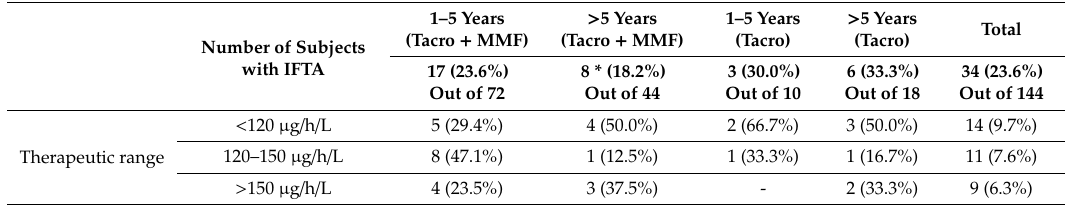
Table 6. Tacro AUC exposure values compliances within therapeutic ranges in patients with kidney alterations.